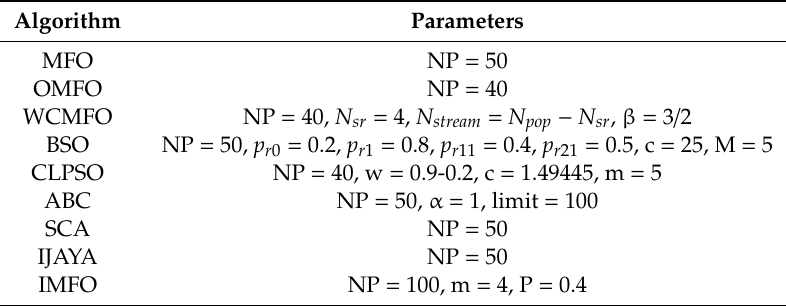
Table A1. Parameters settings of the compared